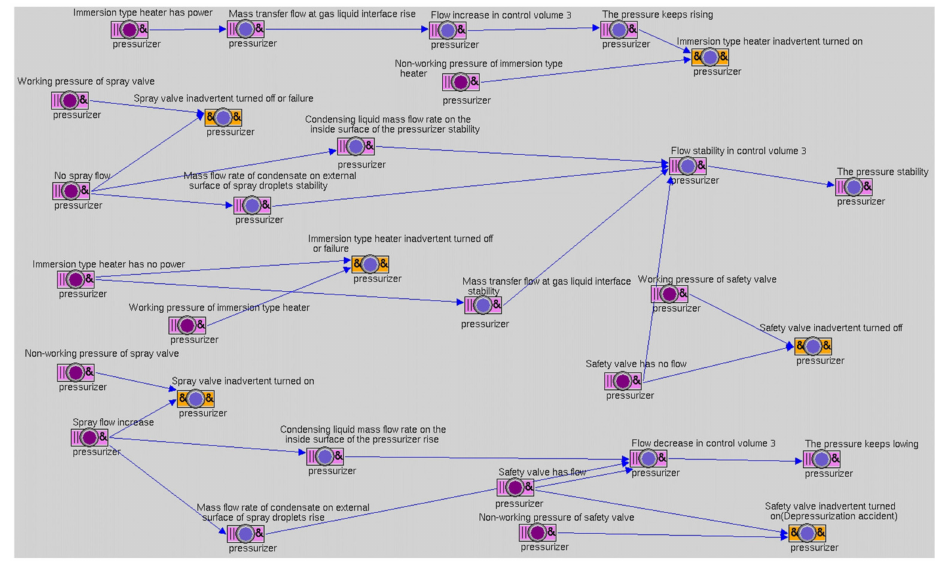
Figure 23. Design of the inference engine for the